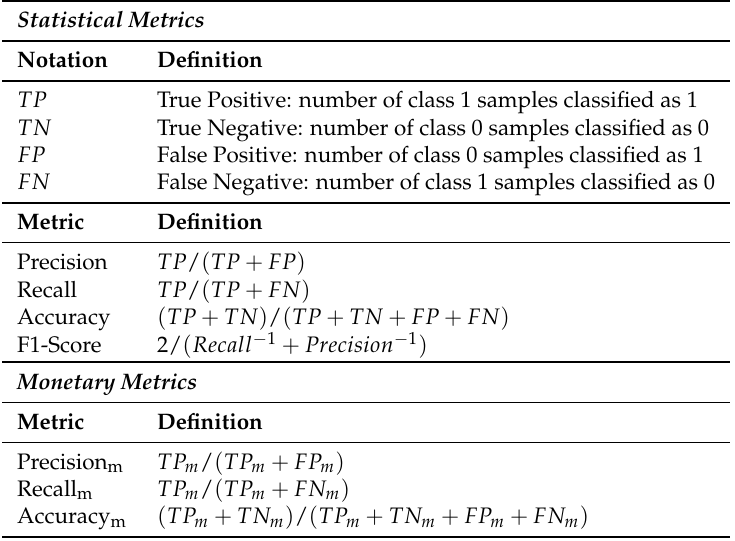
Table 3. Statistical and monetary classifier performance